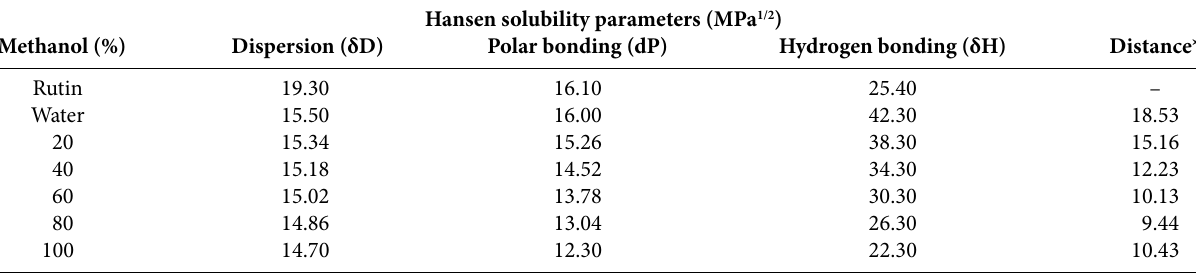
Table 1 . Rutin solubility in different solvent systems based on Hansen solubility